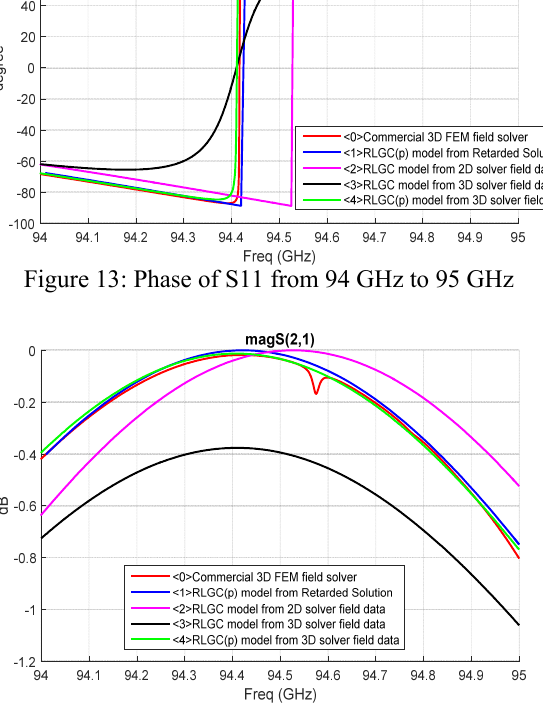
Figure 14: Magnitude of S21 from 94 GHz to 95 GHz